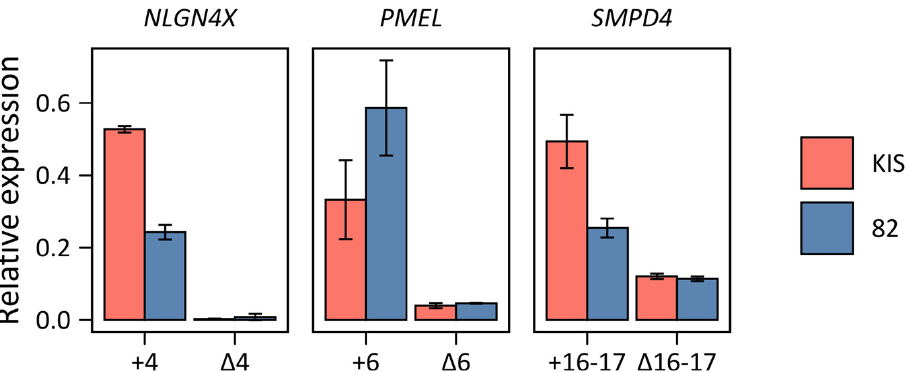
Figure 5. Relative mRNA expression of splice variants determined by qPCR. Bars indicate the average level of expression of the variant relative to the expression of the shared sequence; error bars represent standard deviation.